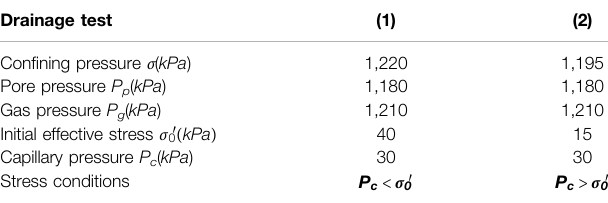
TABLE 1 | Drainage tests under two different hydromechanical stress